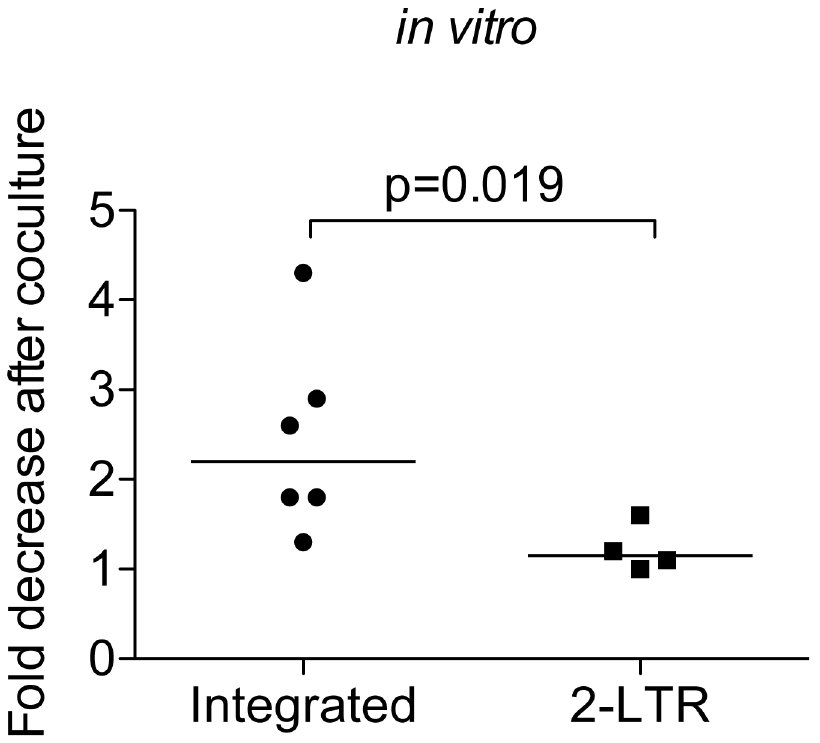
Figure 3. Integrated HIV DNA is preferentially cleared over 2-LTR circles after coculture providing an explanation of the EC phenotype of high levels of unintegrated relative to integrated HIV DNA; this clearance of integrated HIV DNA is not an artifact spinoculation. . EC resting CD4+T cells were inoculated without spinoculation, cultured for 3 days and cocultured with autologous CD8+T cells or cultured alone for 16 hours. DNA was then isolated. The fold change is calculated by dividing the copies of the specific HIV DNA intermediate per resting CD4+T cell (i.e. integrated or 2-LTRs) cultured alone by the copies from the same samples cultured with autologous CD8+T cells. For cocultured samples the level measured was multiplied by 10, which is the dilution factor of effectors added to targets. The line represents the median and p value was calculated using the Mann-Whitney